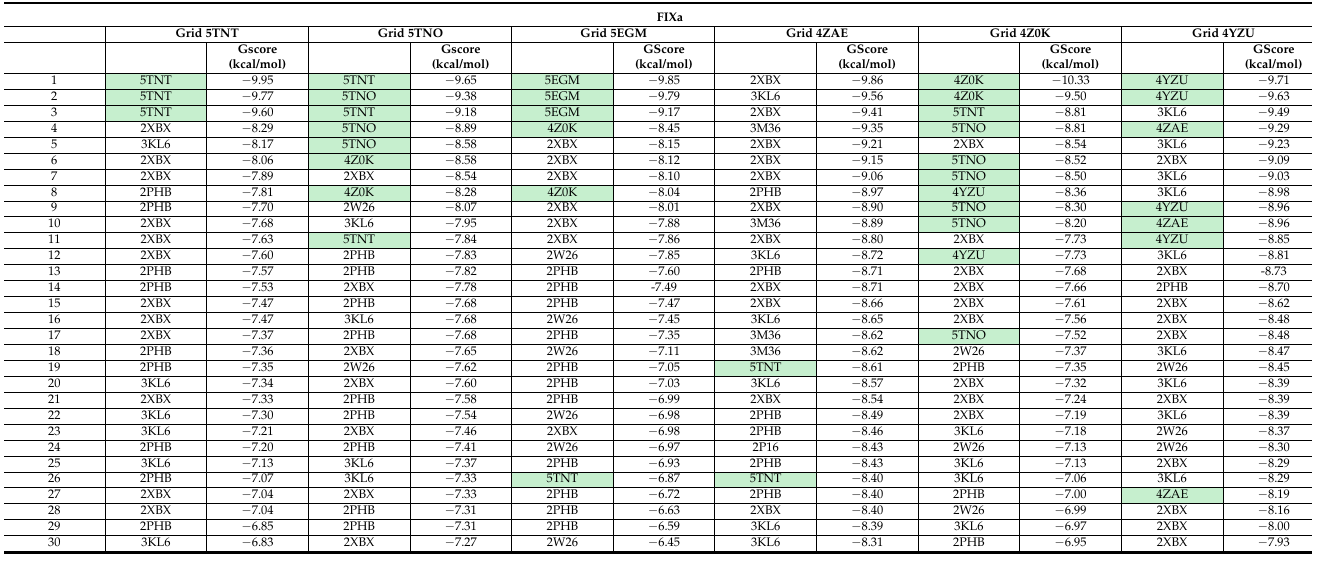
Table 2. Cross docking data with FIXa grids. Green cells with green text represent the FIXa ligands and the red texts indicate moderate binding energy of the corresponding ligand. A longer form of this Table is provided in the Supplementary Information (Table